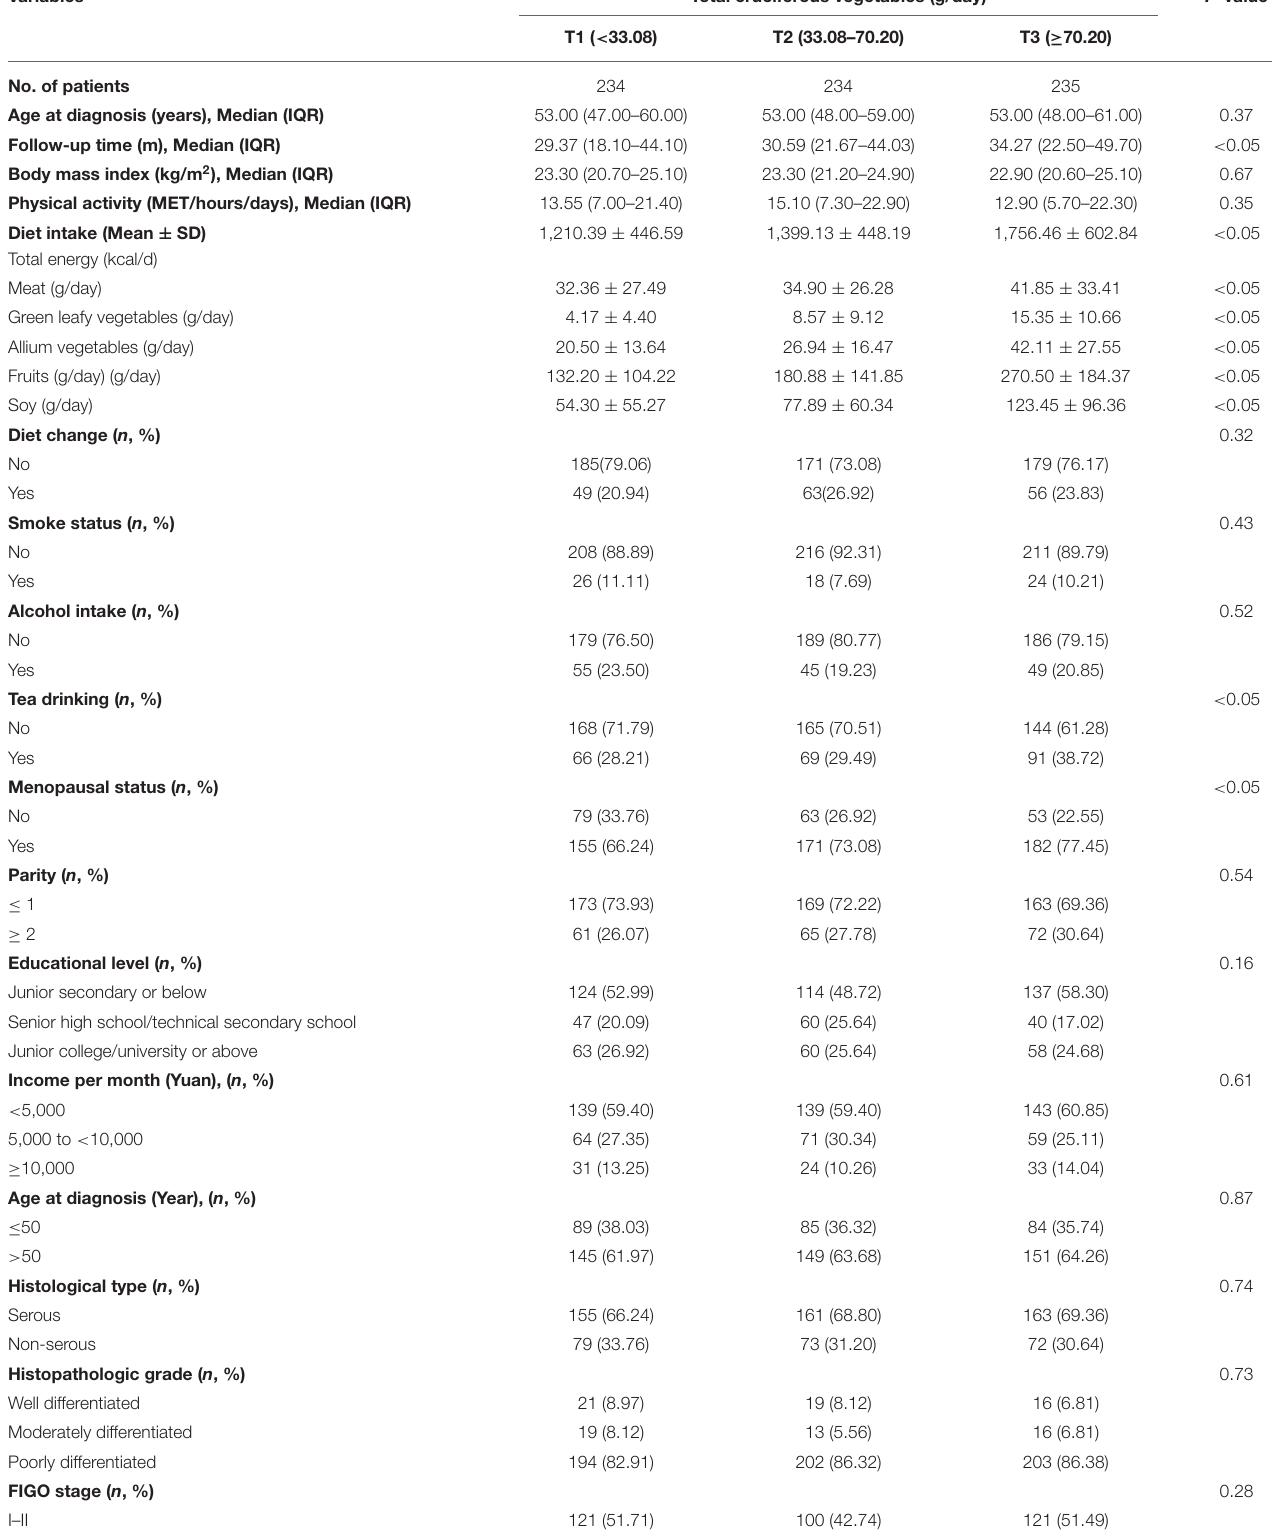
TABLE 1 | General characteristics of ovarian cancer patients according to cruciferous vegetables ( N = 703).